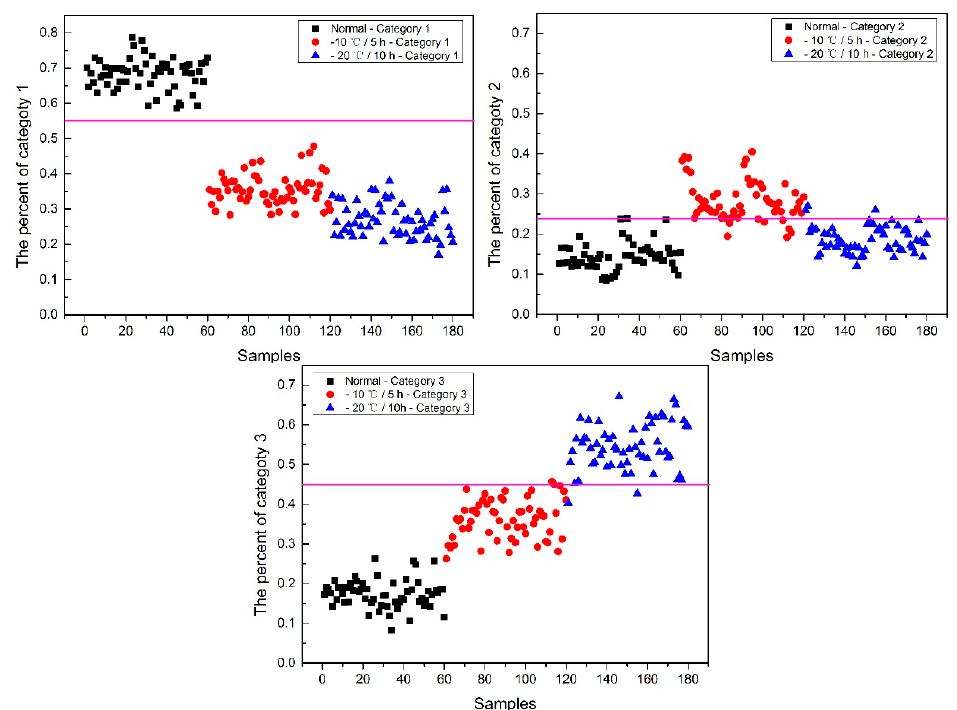
Figure 11. The percentage of each category of Haihe78 with the SPA and PLS-DA model. Table 3. The percentage of the two categories of Haihe78 corn seed samples.